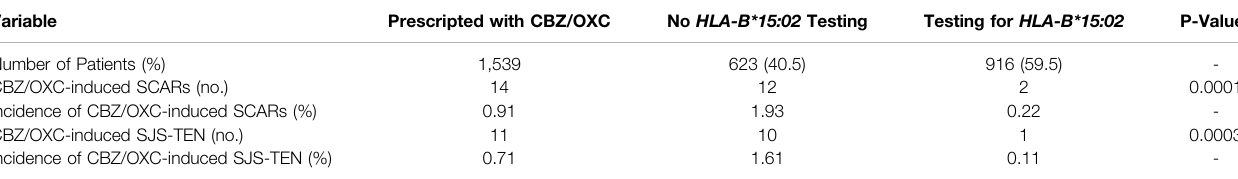
TABLE 4 | Incidence of CBZ/OXC-induced SCAR and SJS between HLA-B*15:02 tested patients and non-tested patients. Variable